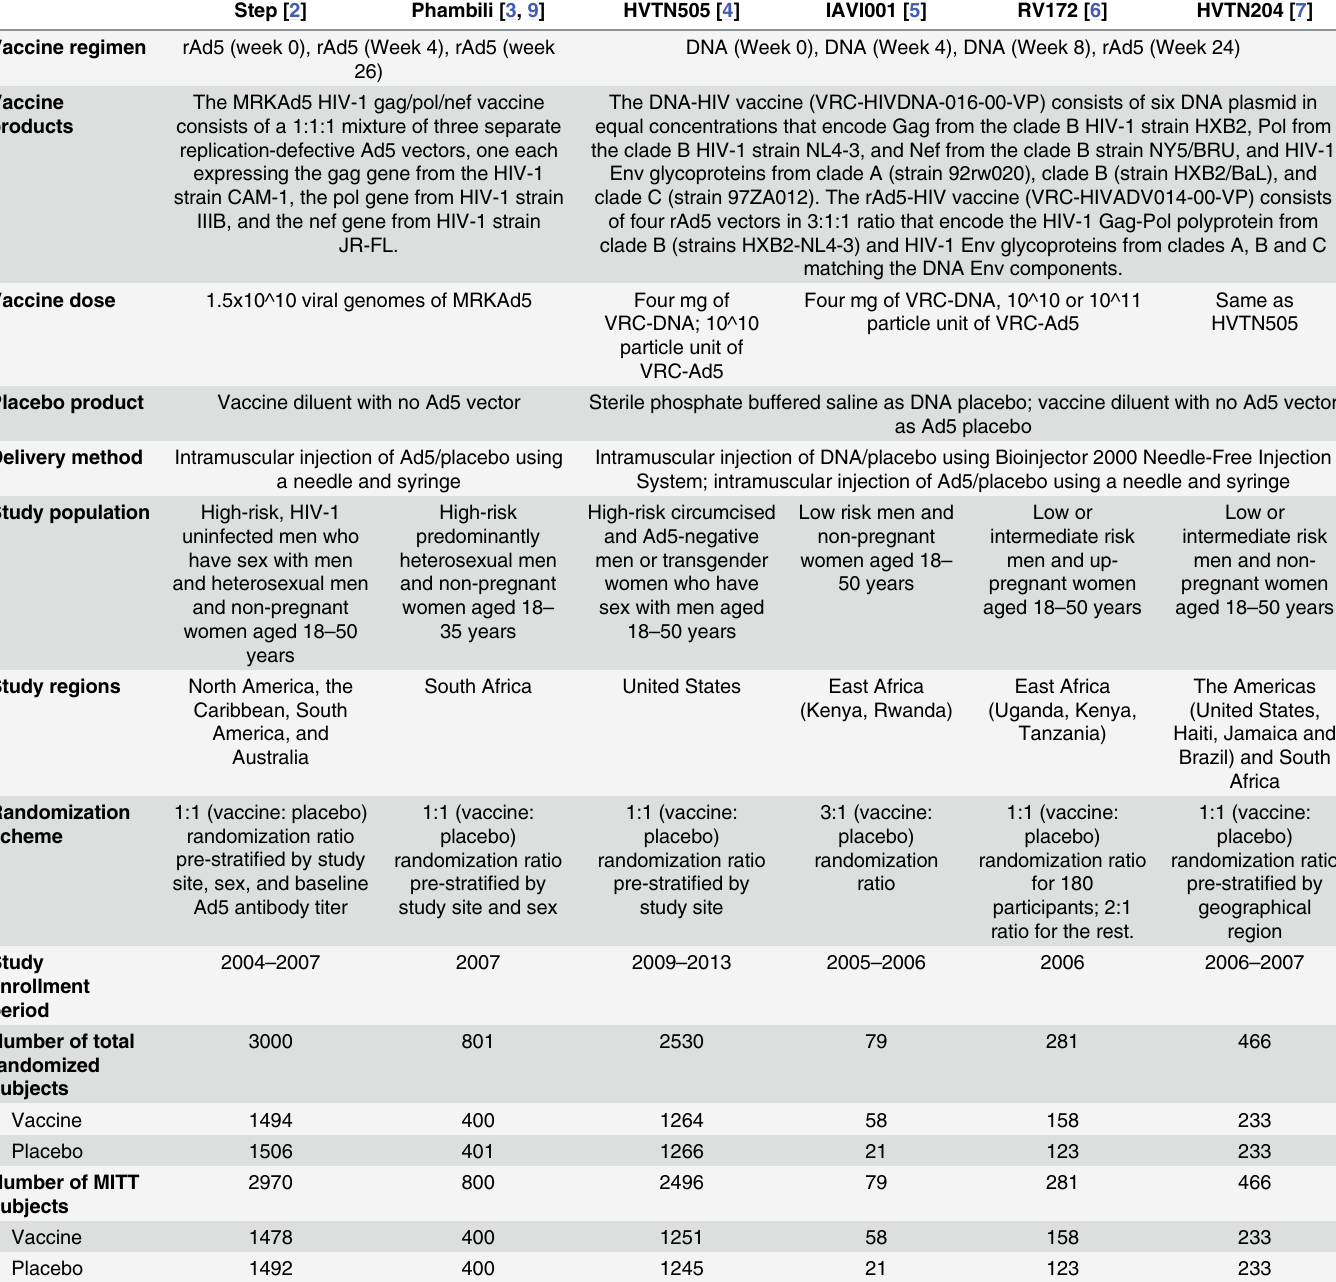
Table 1. Key Features of Individual Studies Included in the Meta-analysis. Step